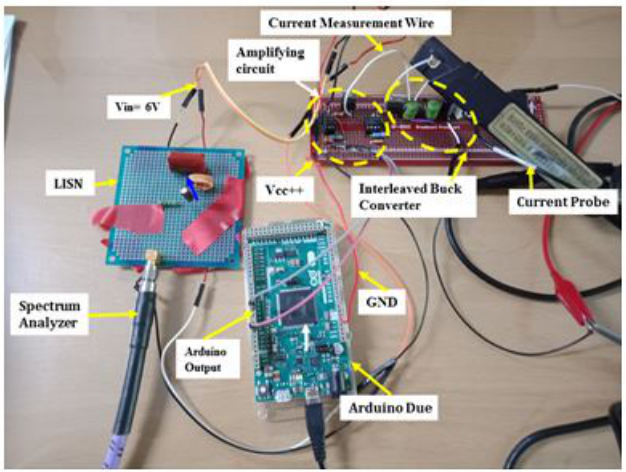
Figure 10. Comparison of the conducted emission results for different random schemes for a simple buck converter.